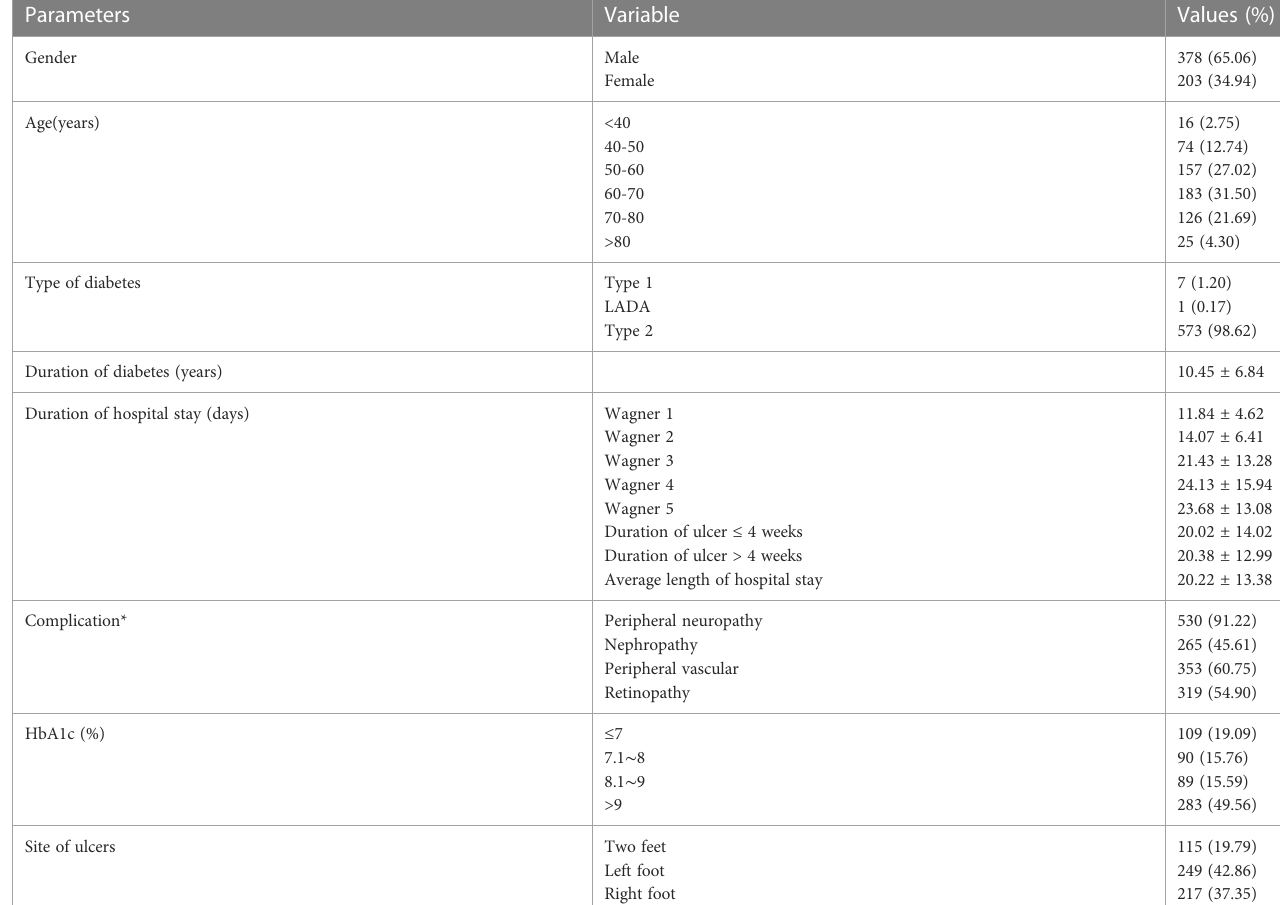
TABLE 1 Clinical characteristics of